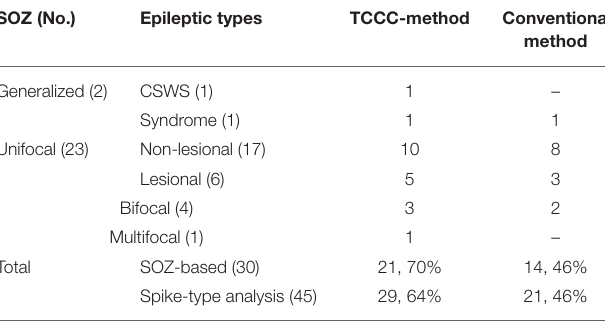
TABLE 2 | Comparison of localization between conventional method and TCCC-method. SOZ